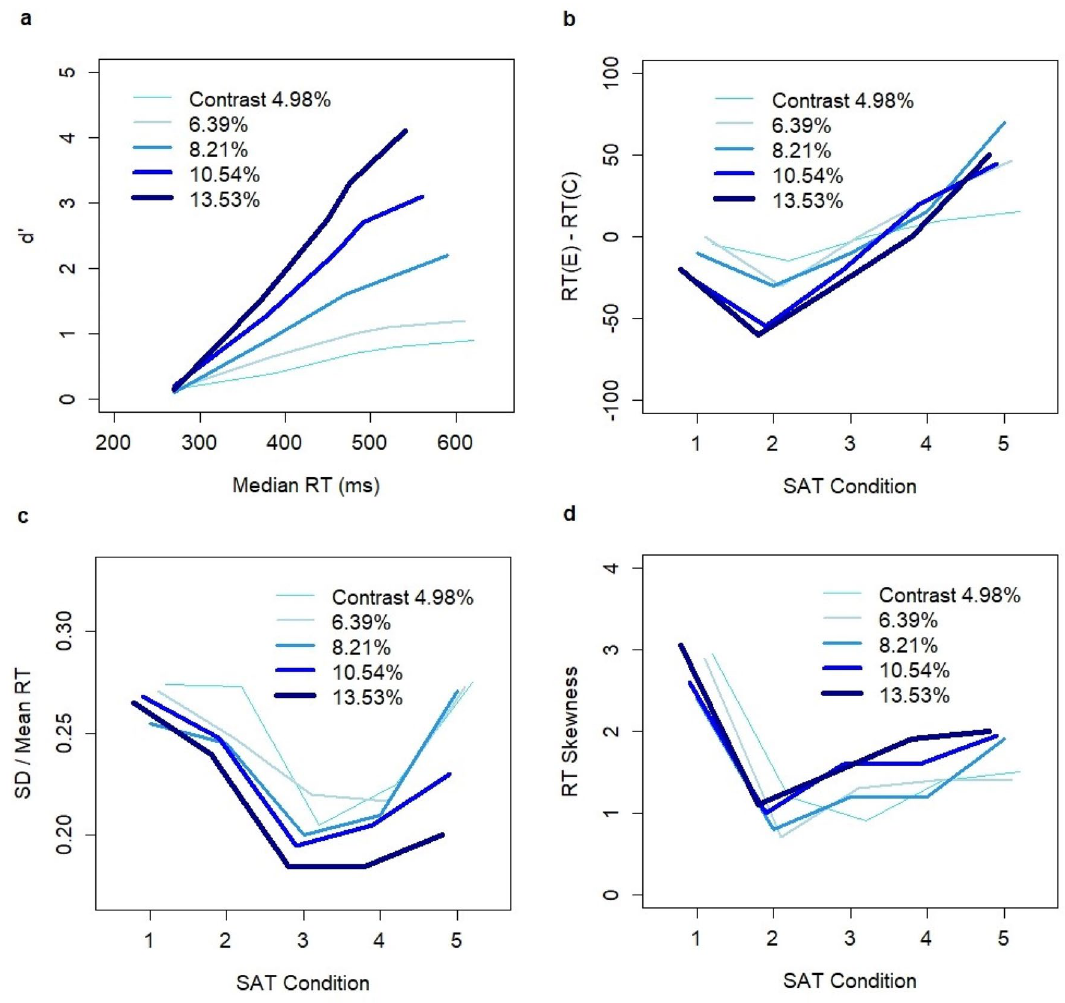
Figure 1. Experimental data of Rafiei and Rahnev 43 . ( a ) Relationship between median RT and d’ for five SAT conditions and five contrast levels where d’ = Φ −1 (correct response rate)–Φ −1 (erroneous response rate) and Φ −1 is the inverse of the cumulative normal distribution N(0,1). The effects of five SAT conditions and five contrast levels on ( b ) the difference in mean RT between erroneous and correct decisions, ( c ) SD/mean RT ratio, and ( d ) RT skewness. This figure was adapted from Fig. 3 in 43 with authors’ permission. In the adaptation, I show the average estimates only (i.e., without reporting error terms) and provide a new figure description. The original figure was featured in the paper 43 published in Scientific Reports under Creative Commons Attribution